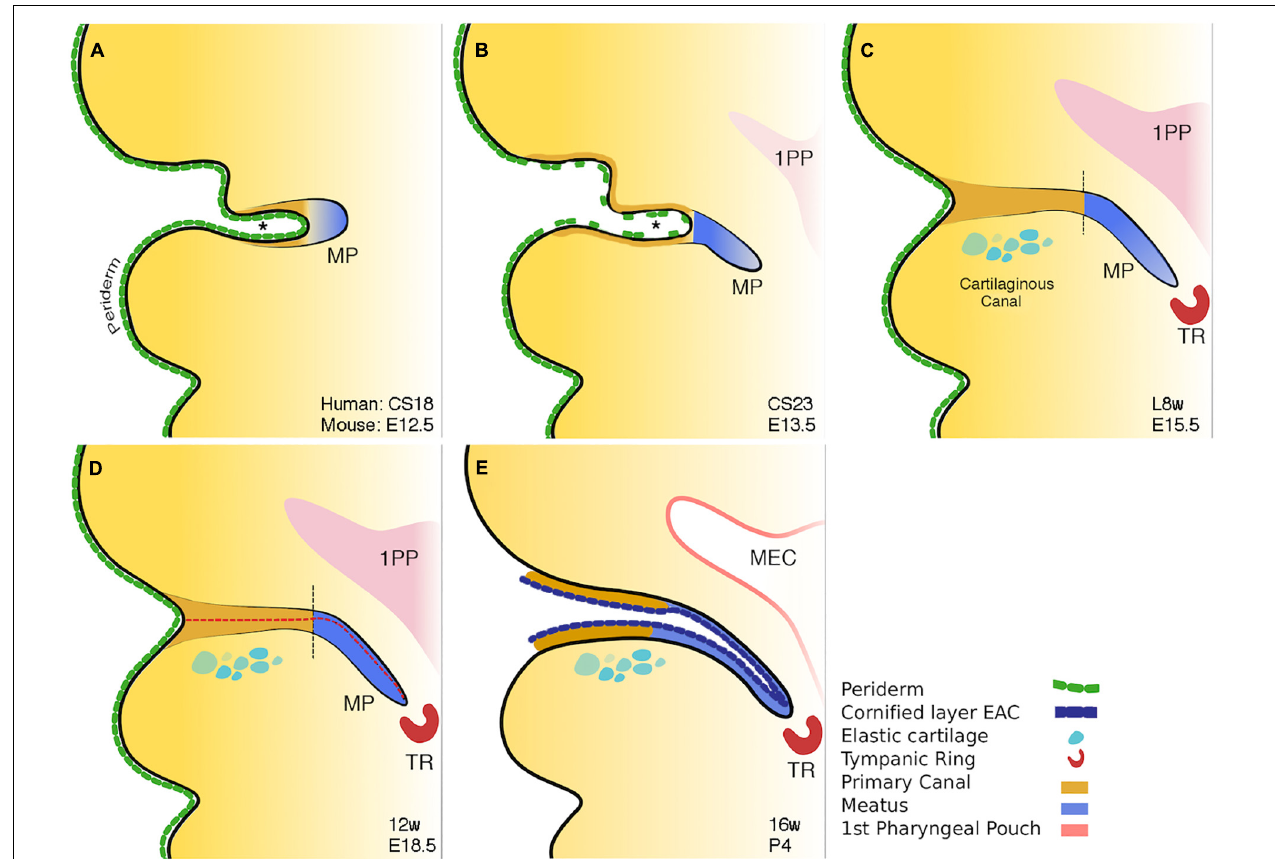
FIGURE 3 | Schematic of mammalian ear canal development. (A) Invagination of the primary canal (marked by *) with a meatal plug at its tip. (B) Extension of the meatus toward the forming middle ear, driven by a potential signal from the tympanic ring. At the same time selective loss of periderm is observed in the primary canal caused by apoptosis. (C) Closure of the primary canal (following loss of periderm layer) and further extension of the meatal plug to reach the tympanic ring. (D) Loricrin expression (red dashed line) marks the site of opening of the canal. (E) Following keratinocyte differentiation, the whole external ear canal opens, with the upper/rostral wall of the meatal plate forming the outer surface of the tympanic membrane. Vertical black dashed lines in C and D between brown and blue regions represent the two distinct parts of the ear canal. Schematic taken from Fons et al.